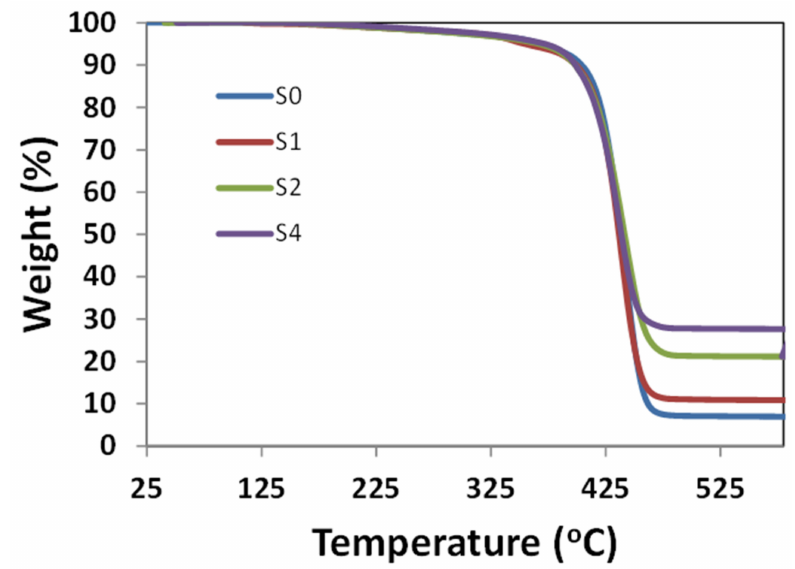
Figure 8. TGA analysis of pristine PS and PS/sepiolite nanocomposites.